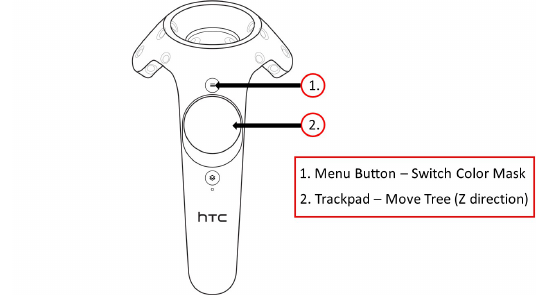
Figure 5. Schematic of the VR functionnalities associated to the left controller.